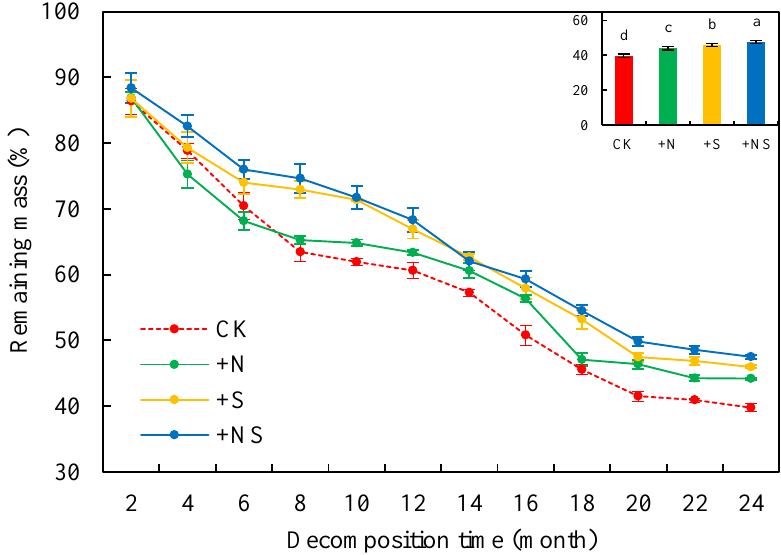
Figure 2. Remaining litter mass (% of the initial amount) during the decomposition process. Values are the averages of three plot replicates ± standard deviations. Different lowercase letters in the histogram denote significant differences between distinct treatments at the end of this study based on one-way ANOVA ( p < 0.05; Fisher’s LSD test adjusted using the Bonferroni correction). CK, no added N or S; + N, added N but no added S; + S, added S but no added N; and + NS, added N and S. Table 1. Decomposition coefficient ( k -value) and times required for 50% ( T 50% ) decomposition under different treatments based on one-way ANOVA.